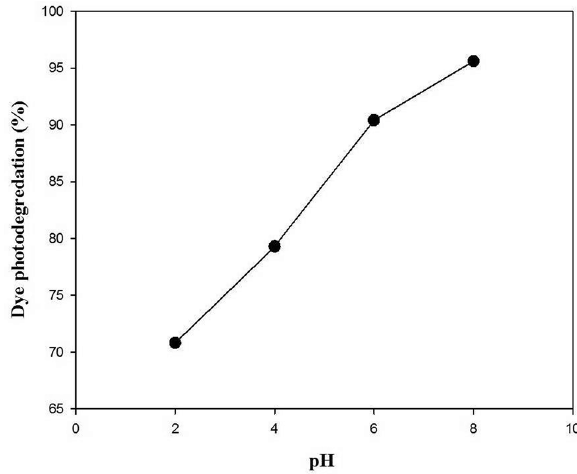
Fig. 5 Effect of pH on the photodegradation of bromophenol blue